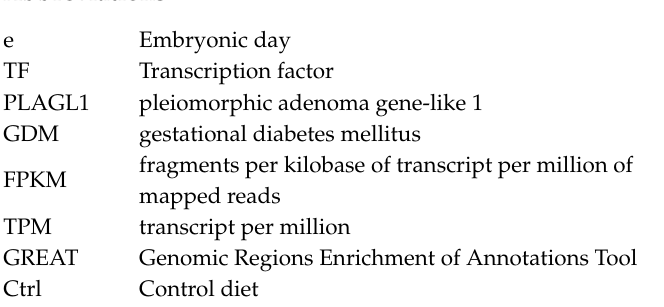
Figure S1: Transcription factor analysis, Table S1: E9.5-specific enhancer gene ontology terms, Figure S2: RNAscope showing Plagl1 expression in the allantois and labyrinth, Table S2: E9.5 highly expressed, upregulated transcription factors, Figure S3: Disease ontology for downregulated genes, Table S3: Samples used for Plagl1 expression in GDM placentas, Figure S4: PLAGL1 target gene and enhancer activity, Table S4: DESeq2 output, Table S5: List of primers used for RT-qPCR, Table S6: HTR-8 / SVneo HISAT2 results, Table S7: Target enhancer